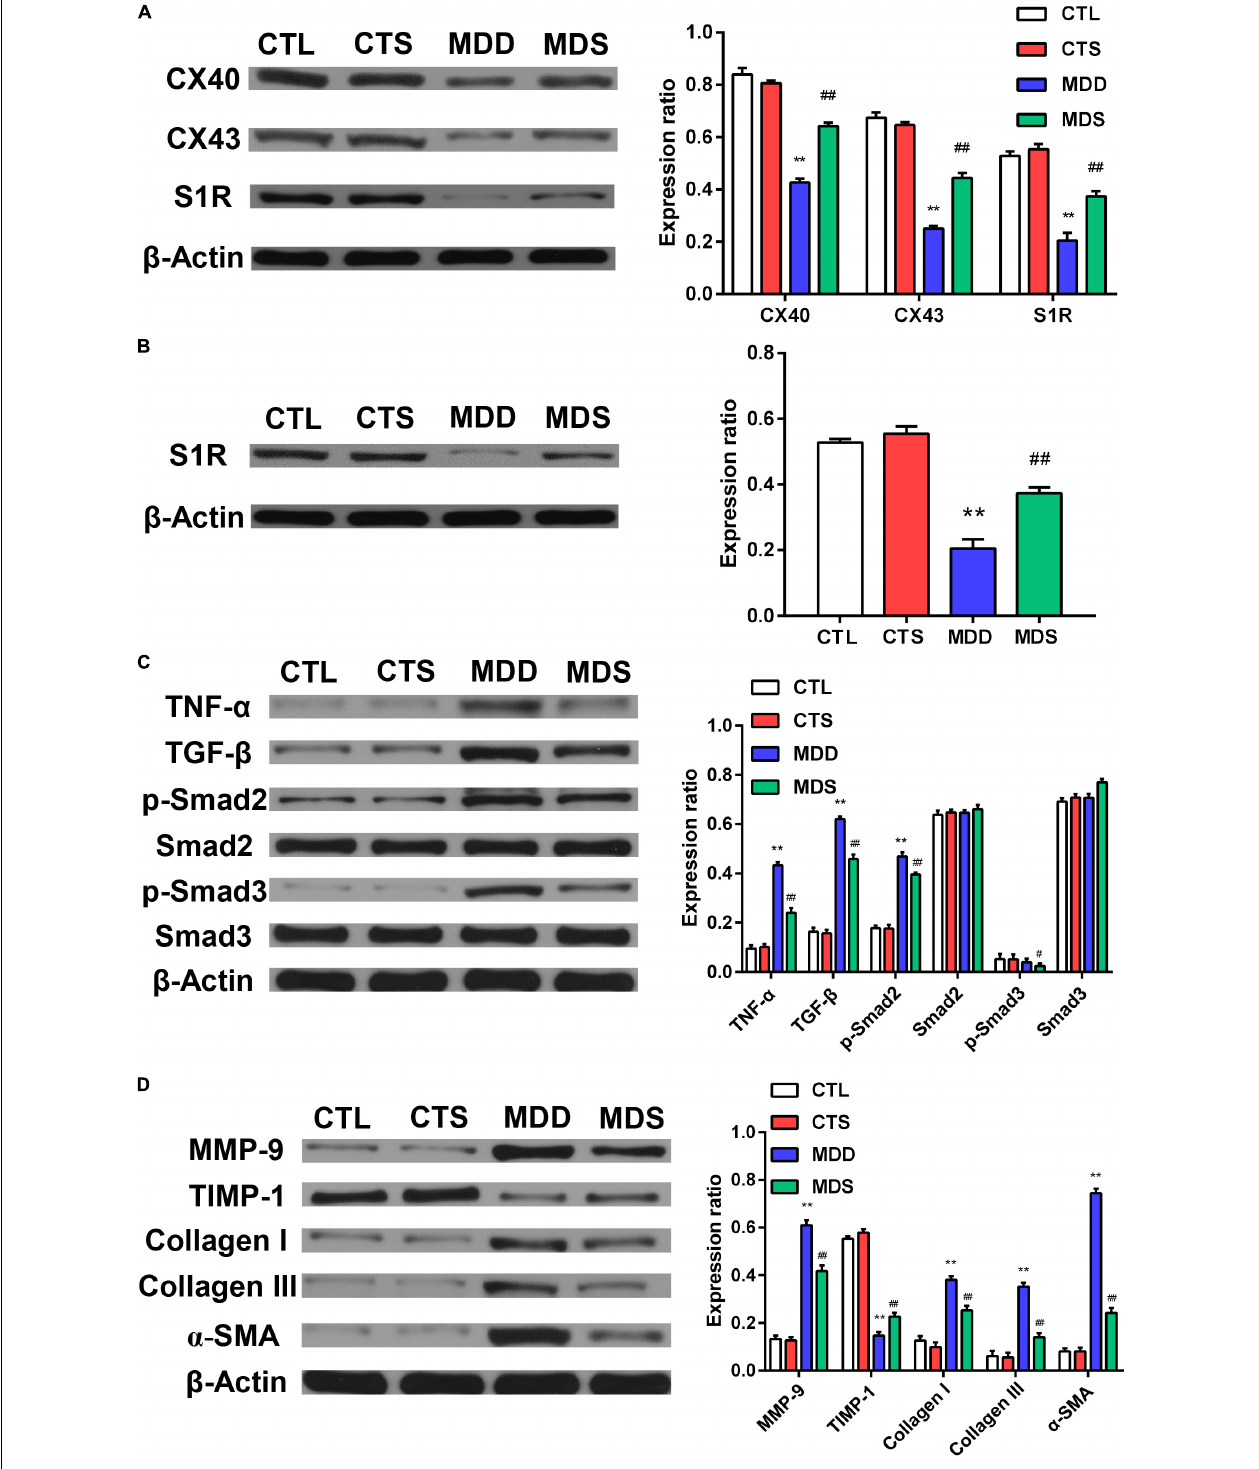
FIGURE 5 | Quantification of the expression levels of gap junction and inflammatory pathways, collagen disposition, and S1R proteins. (A) The MDD group showed downregulation of Cx40, Cx43, and S1R in left atria. The MDS group showed partial reversals of downregulation ( n = 3). (B) The MDD group showed downregulation of S1R in the hippocampus and the MDS group showed partial reversals of these regulatory changes ( n = 3). (C) The MDD group showed upregulation of TGF- β /Smad2/3 pathway. (D) The MDD group showed more collagen disposition. S1R = sigma-1 receptor. ∗∗ P < 0.01 vs. CTL group; # P < 0.05, ## P < 0.01 vs. MDD